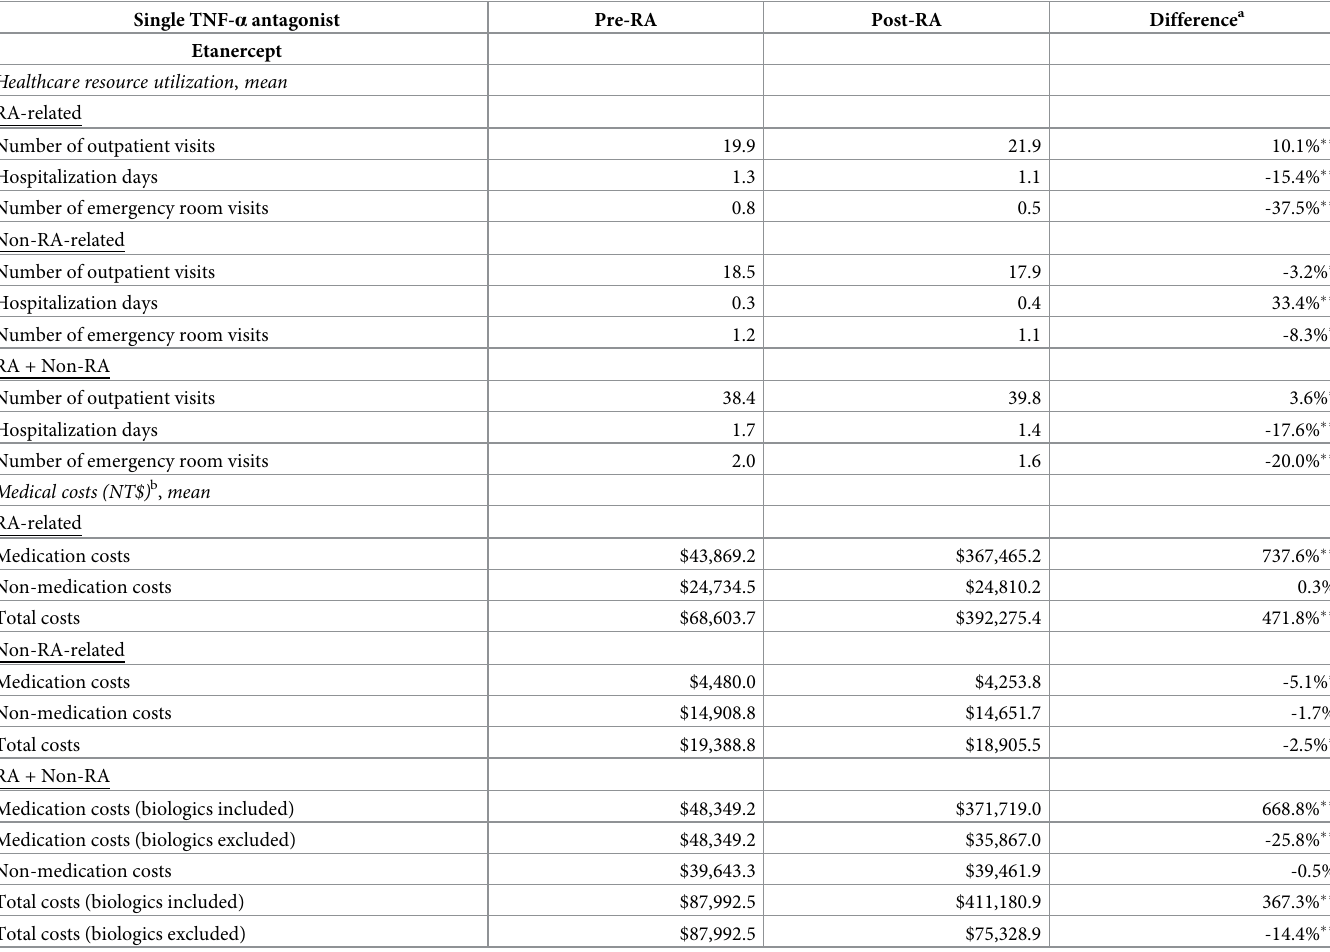
Table 2. Differences in healthcare resource utilization and direct medical costs of patients with rheumatoid arthritis (RA) before and after the use of single biologic